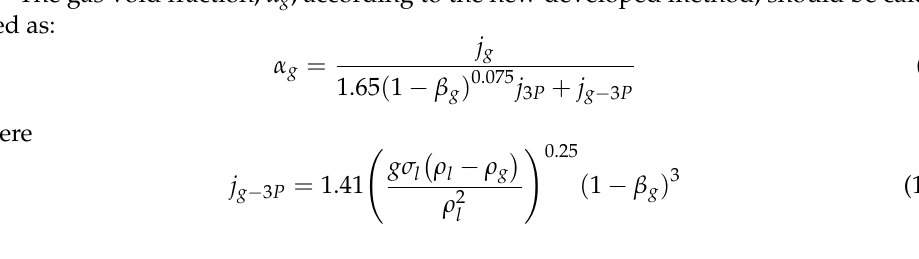
Figure 9. Statistical analysis of method applied for determining void and volume fraction of phases for downward three-phase oil–water–air flow ( a ), and ( b ) values of experimental points located within the range of <30% of the MAE of experimental points, in accordance with the Nowak method [24].